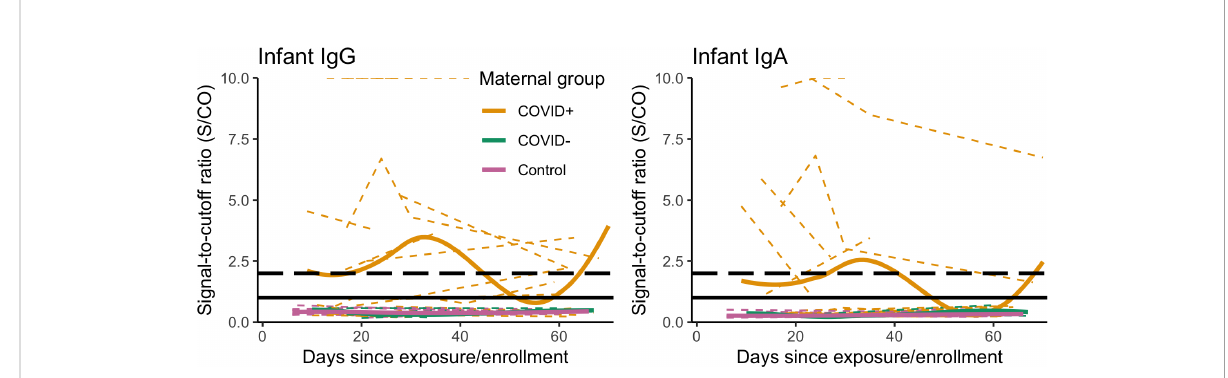
FIGURE 2 Individual infant IgG and IgA S/CO trajectories (dashed, colored lines) with group-level loess smoothes (solid, colored lines) over two months following maternal infection onset or enrollment, by maternal study group: COVID+ (n = 25, n obs = 66); COVID- (n = 7, n obs = 18); and BF control group, excluding samples collected post-maternal vaccination (n = 15, n obs = 35), S/CO=1.0 (solid black line), S/CO=2.0 (dashed black line). Y-axis is truncated at S/CO = 10; samples with S/CO between 10-20 not shown (IgG n subj = 3, n obs = 11; IgA n subj = 2, n obs =